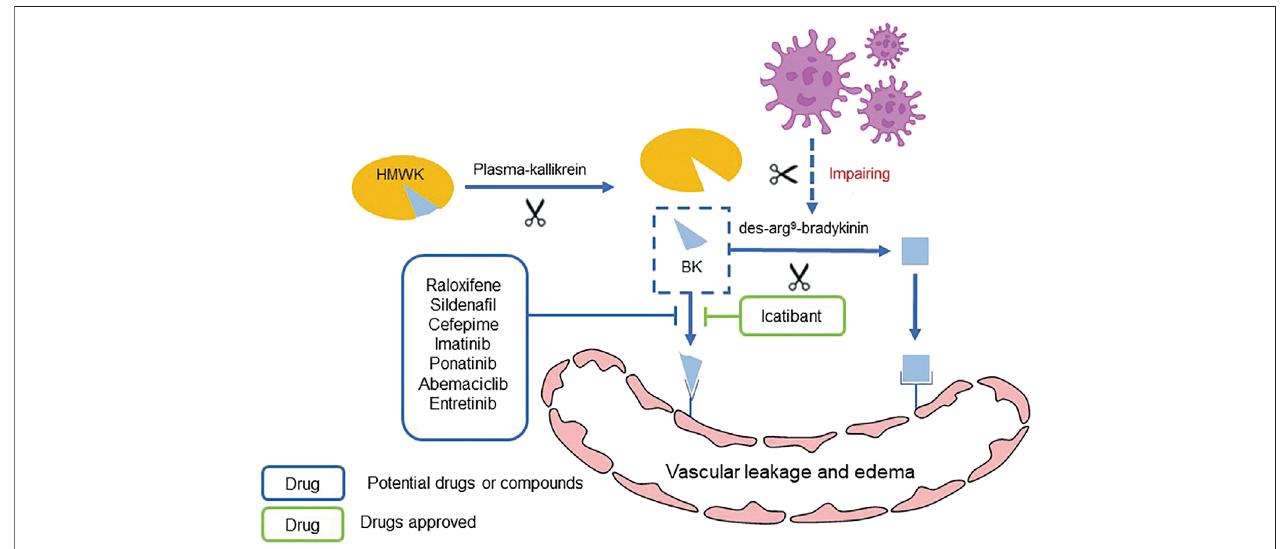
FIGURE 5 | Mechanism of BK inducing pulmonary edema and potential